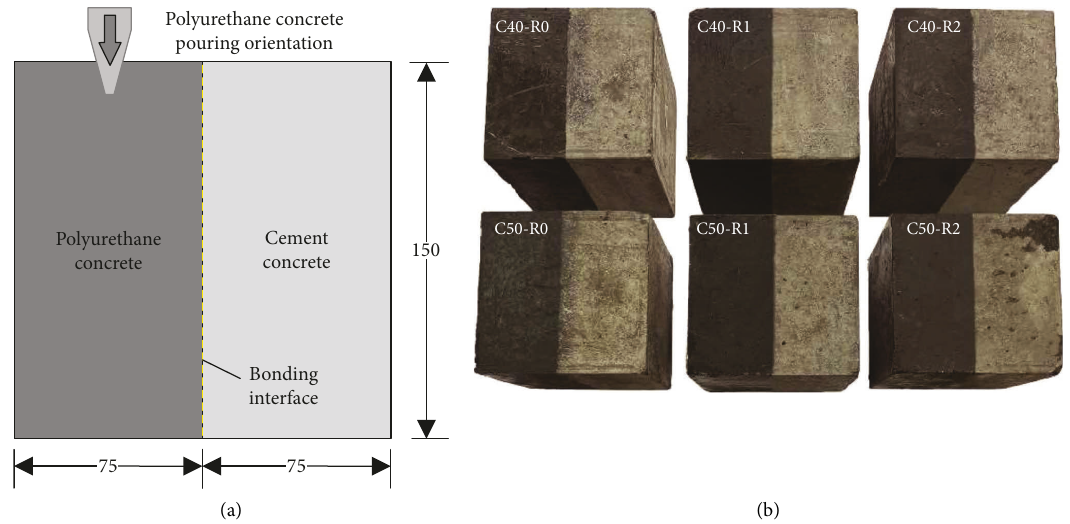
Figure 8: Specimen casting diagram and splitting bond specimens.